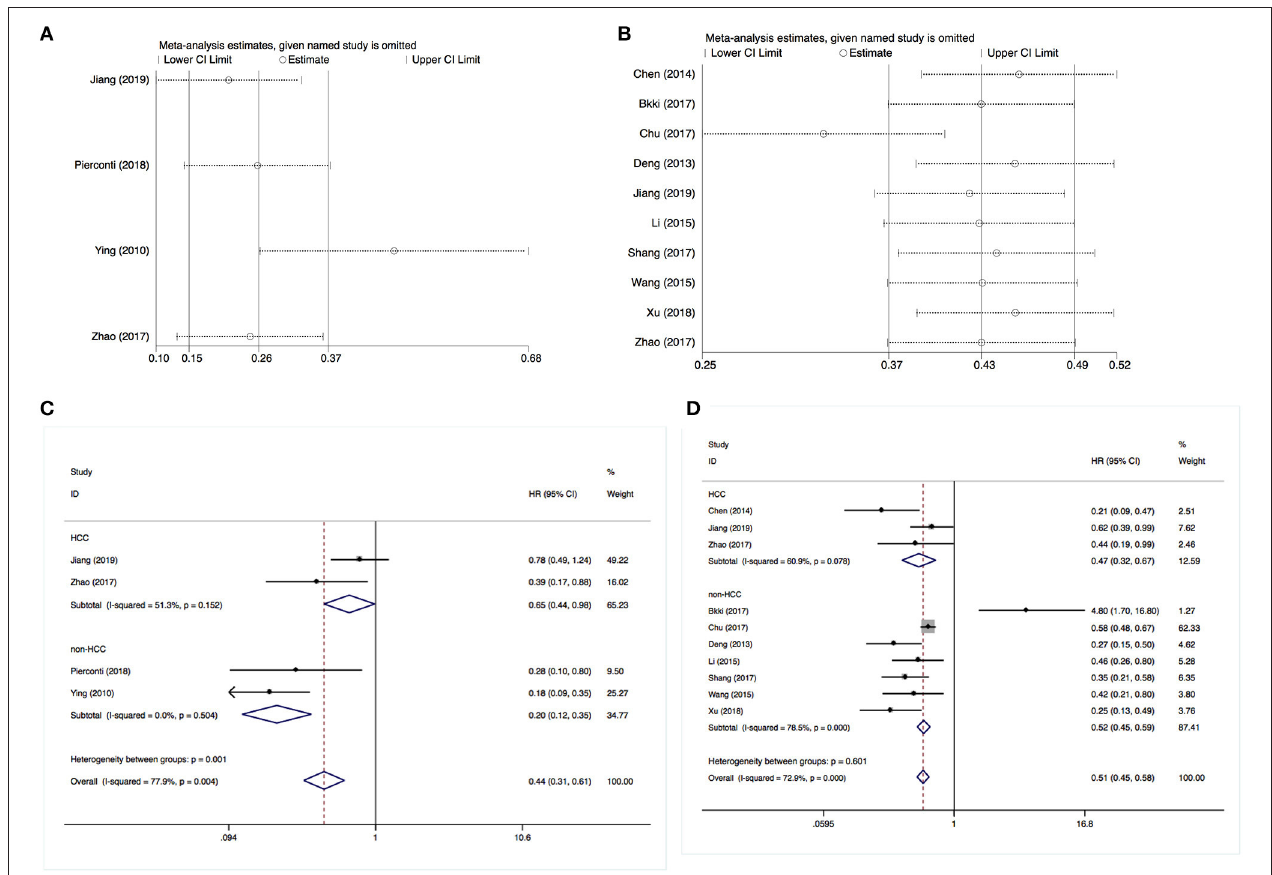
FIGURE 4 | Sensitivity and stratification analysis results. (A) Sensitivity analysis of disease-free survival. (B) Sensitivity analysis of overall survival. (C) Stratification analysis of disease-free survival. (D) Stratification analysis of overall